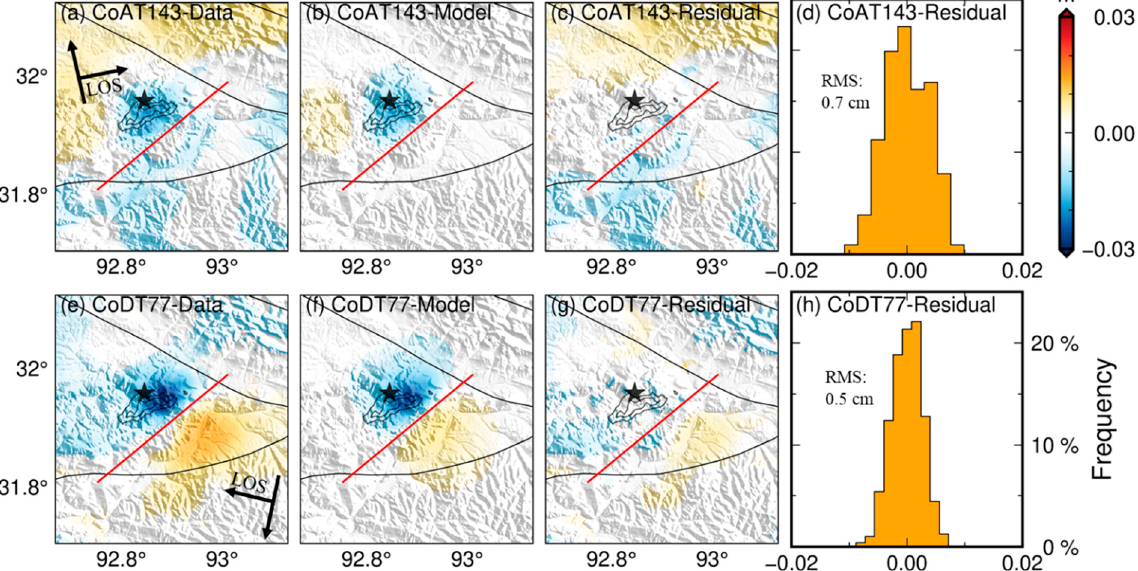
Figure 2. Observed and modeled coseismic ground displacement in satellite line of sight (LOS) in both ( a – d ) AT143 and ( e – h ) DT77 tracks. Positive values indicate relative motion of the ground surface toward the satellite (LOS range decrease). First column: the observed surface displacement fields; Second column: model predictions; Third and fourth columns: residuals between observations and models and the histograms of residuals. Black contour with a 0.1 m interval is the coseismic slip model. Red line and black star represent the surface trace of the modeled seismogenic fault and the epicenter estimated in this study based on InSAR data, respectively.